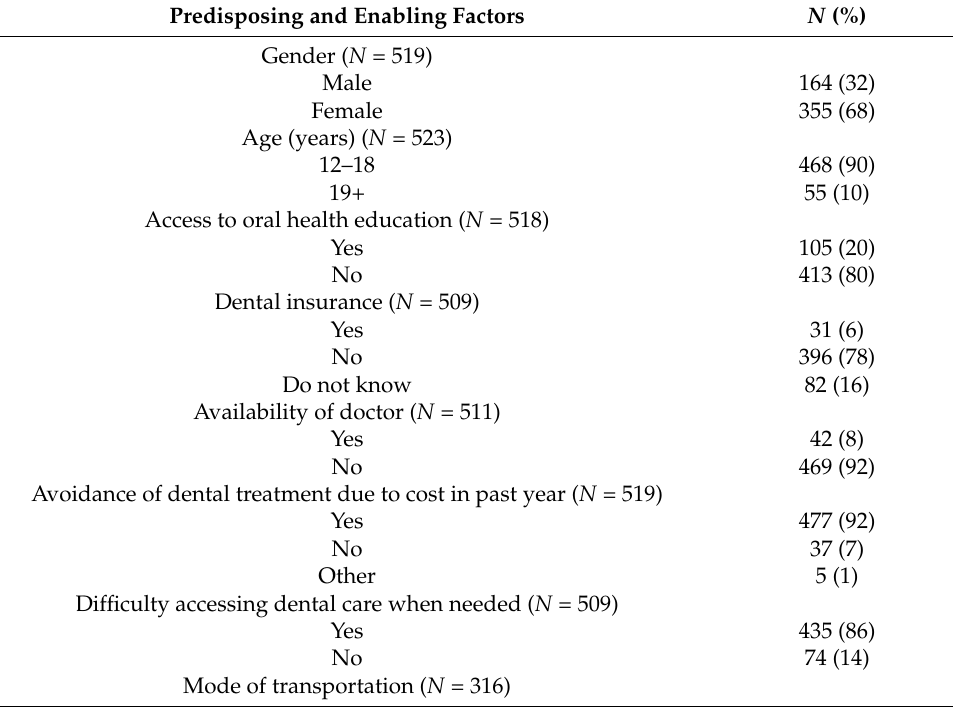
Table 1. Predisposing and enabling factors according to the A&N framework of health service utilization ( N =